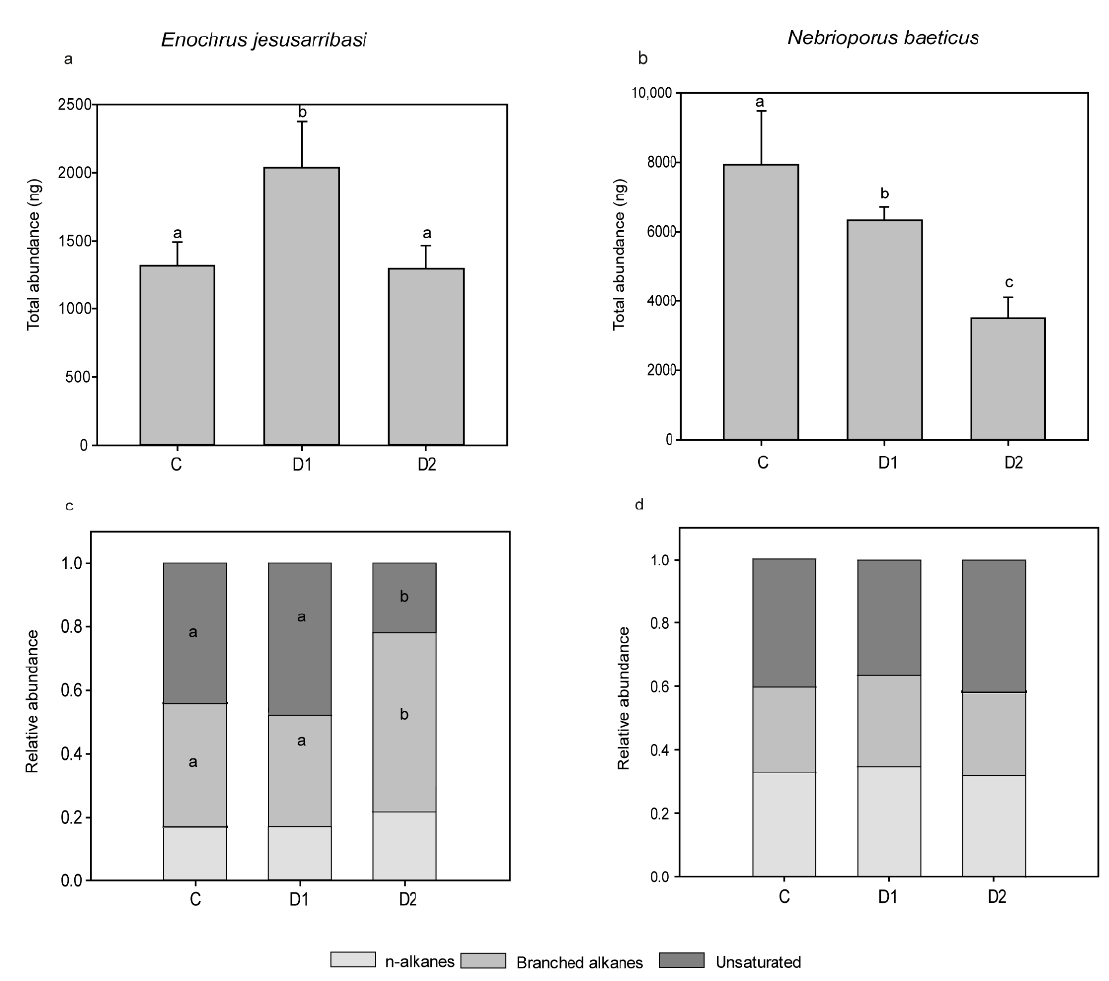
Figure 3. Total amount of cuticular hydrocarbons (CHCs) (Mean ± S.E.) ( a , b ), and mean relative abundance of the major CHC classes ( c , d ) in the different treatments (C: water control, D1: individuals from the control exposed to desiccation and D2: individuals from the prior desiccation exposed to a subsequent desiccation) of Enochrus jesusarribasi ( left ) and Nebrioporus baeticus ( right ). Lowercase letters indicate significant differences in Bonferroni post hoc tests ( p < 0.05) between treatments ( a , b ) and between treatments within each major CHC class ( c , d ).